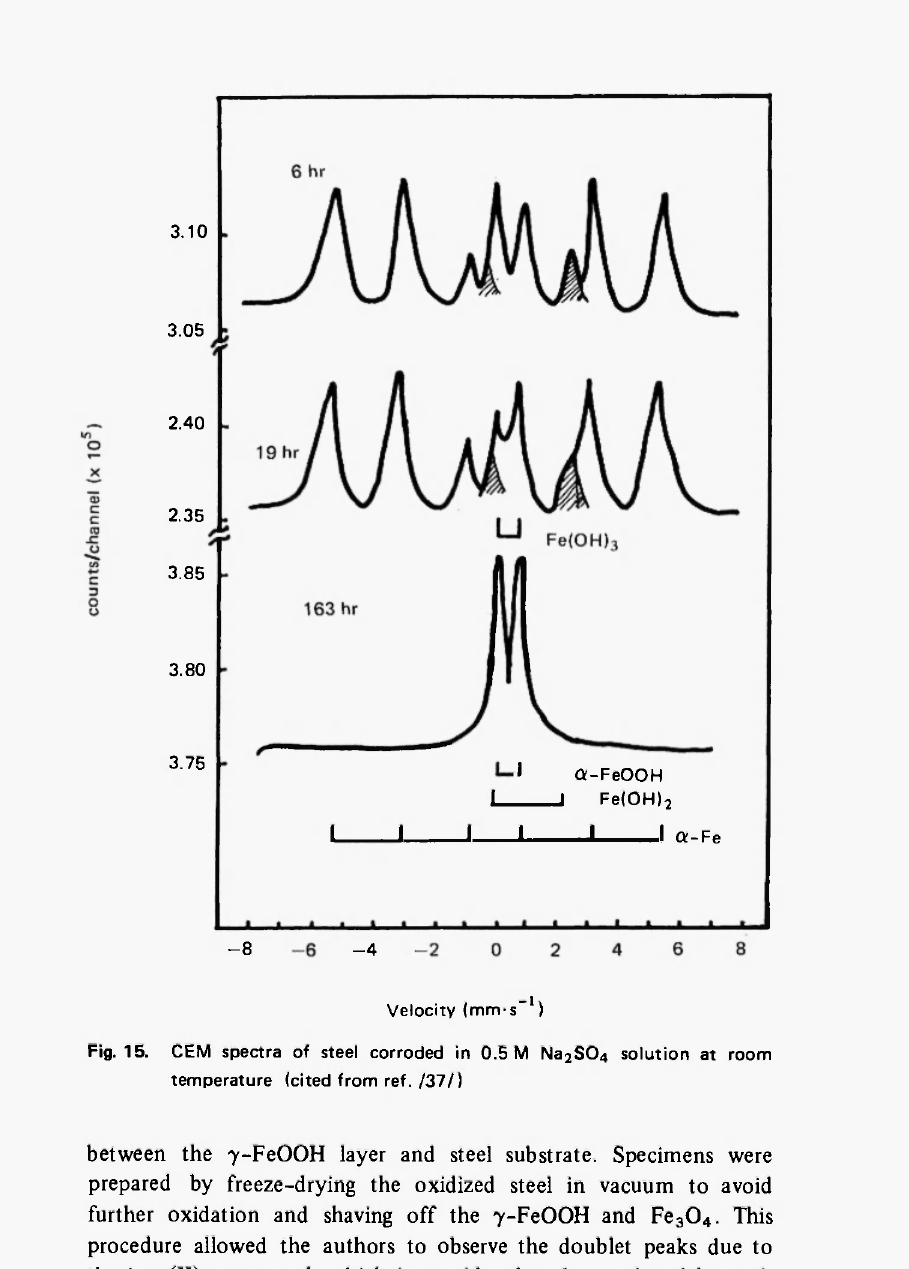
Fig. 15. CEM spectra of steel corroded in 0.5 Μ Na 2 S0 4 solution at room temperature (cited from ref.